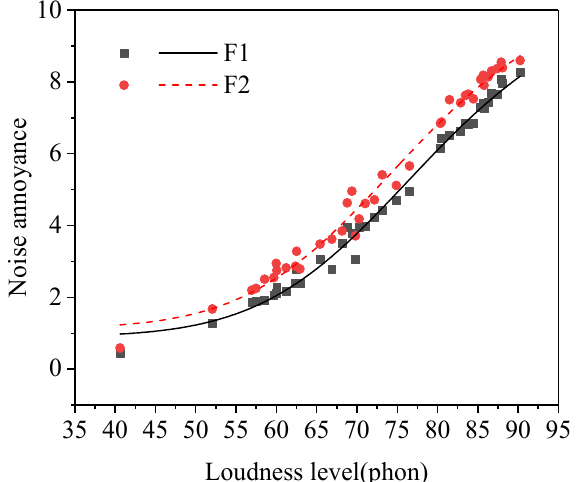
Figure 7. Noise annoyance of two groups of subjects with different noisy degrees in the workplace (subgroups F1–F2).